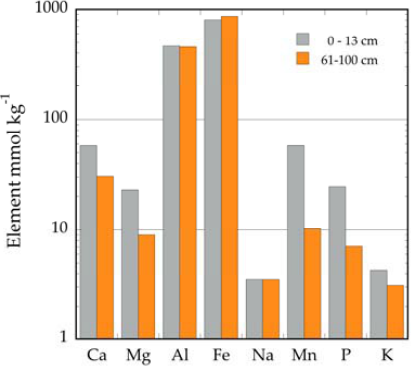
Figure 3. Elemental composition of clay soils on karst in El Tallonal, Arecibo, Puerto Rico. Values for the A horizon (0–13 cm) and the C horizon (61–100 cm) were generated from [28].